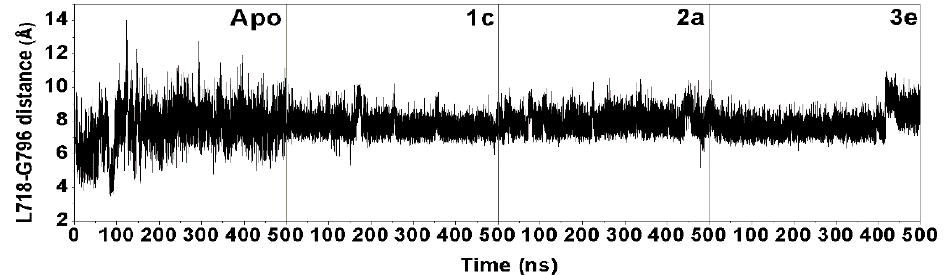
Figure 6. Time-dependent distance between the centers of mass of residues L718 and G796 for the apo and complex forms of the EGFR over a 500 ns MD trajectory.